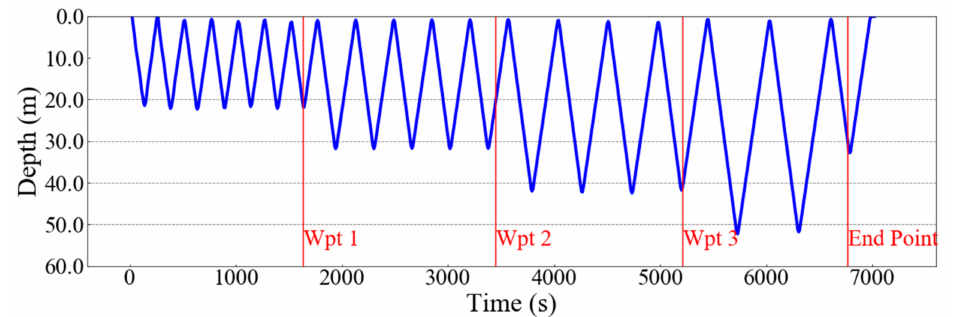
Figure 8. The depth of the glider under the control of a depth controller, which changed the maximum dive depth when a waypoint was